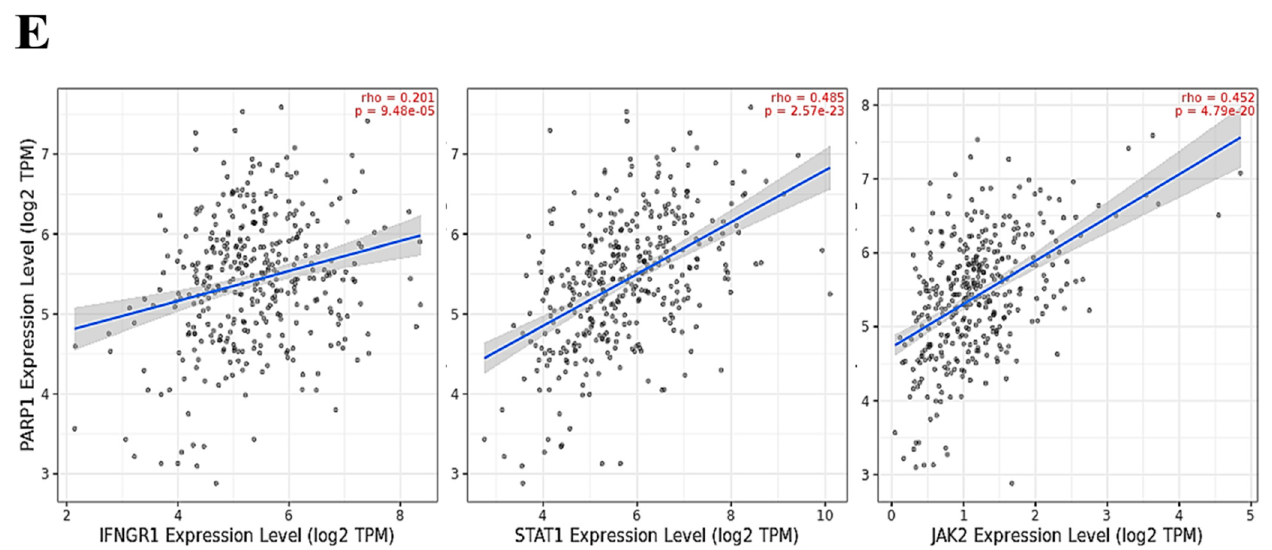
Figure 6. PARP1 expression associated with poor liver cancer patients’ overall survival. ( A ) Schematic representation of the interaction of the IFNGR-JAK-STAT1-PARP1 signaling proteins with the STRING analysis. ( B ) Transcription level of PAPR1 in different types of cancers (oncomine and TCGA) types. ( C ) K-M plot denoting the overall survival of liver cancer patients. ( D , E ) Expression and correlation analysis of PARP1 in liver cancer.